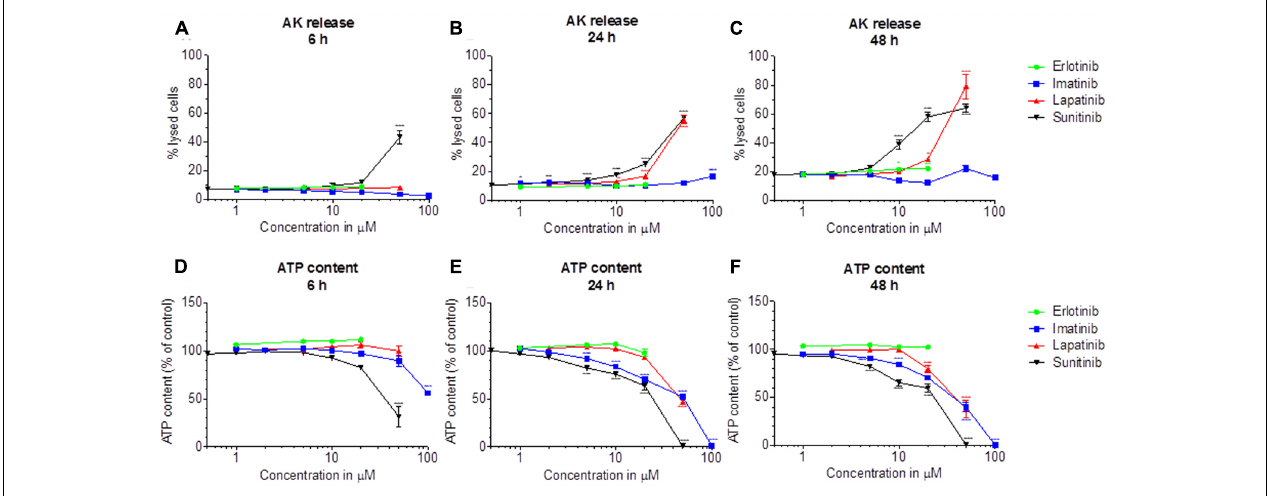
FIGURE 1 | Cytotoxicity and effect on the intracellular ATP content in HepG2 cells. Cytotoxicity was assessed by the release of AK. (A–C) : Cytotoxicity after drug exposure for 6, 24, and 48 h, respectively. (D–F) : Cellular ATP content after drug exposure for 6, 24, and 48 h, respectively. Data are expressed as % AK release in the presence of 0.5% Triton X (set at 100%) or as % ATP content in the presence of 0.1% DMSO (set at 100%). Data represent the mean ± SEM of at least three independent experiments. ∗ p < 0.05, ∗∗ p < 0.01 or ∗∗∗ p < 0.001 versus DMSO control.